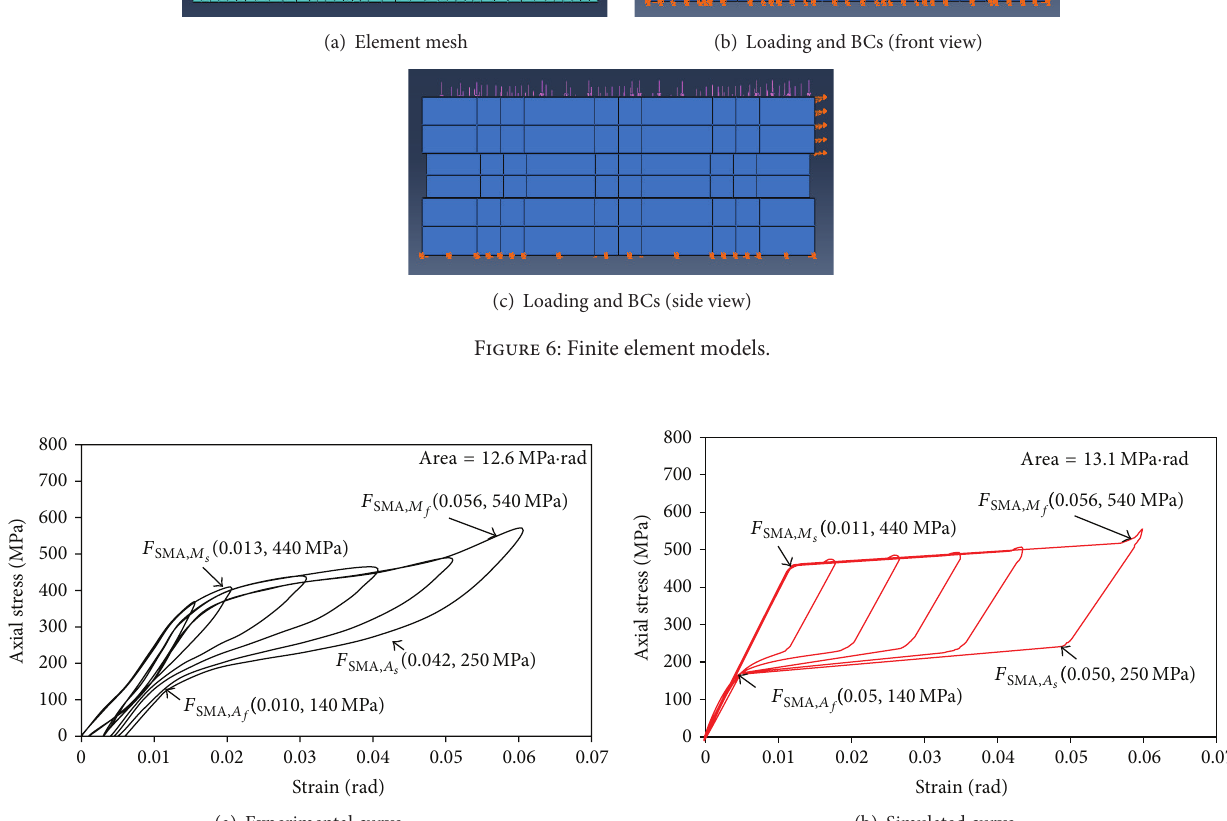
Figure 7: Simulated superelastic SMA